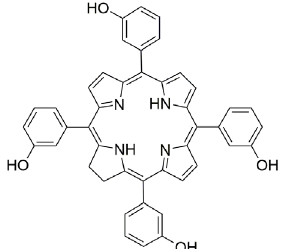
Figure 6 - Temoporfin structure.